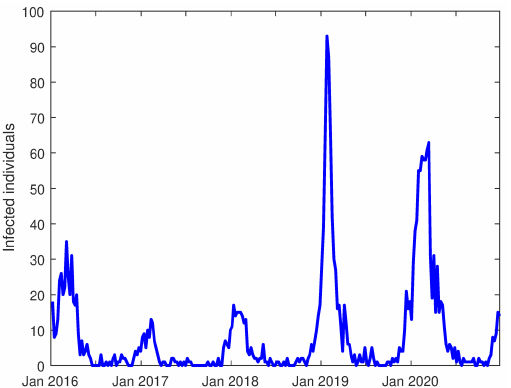
Figure 1. Weekly dengue data for infected individuals from January 2016 to December 2020 in Kupang city,